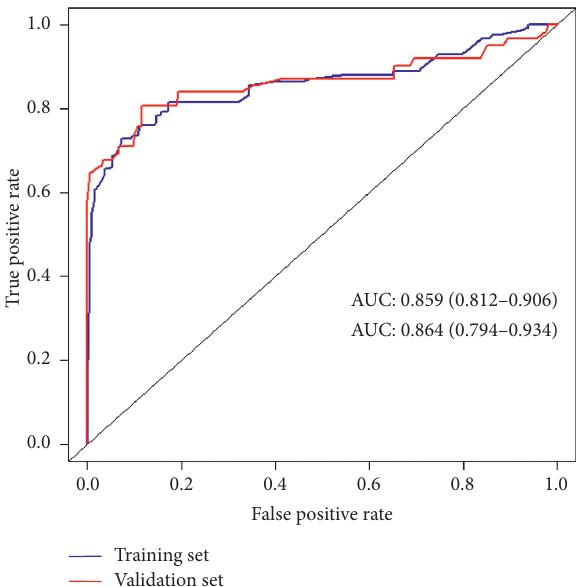
Figure 4: Receiver operating characteristic curve of the untreated nomogram prediction in the